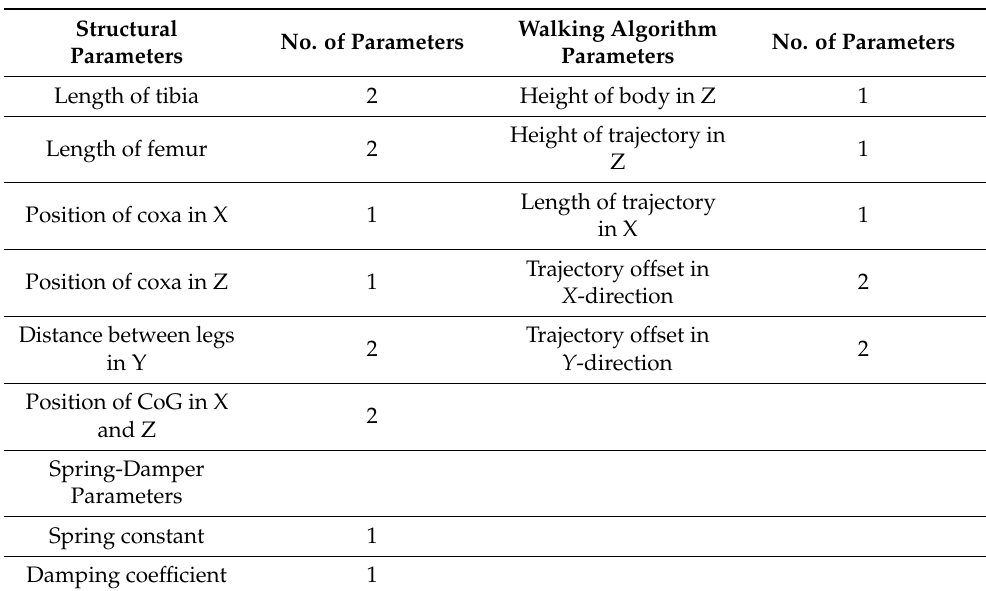
Table 6. Reduced optimization